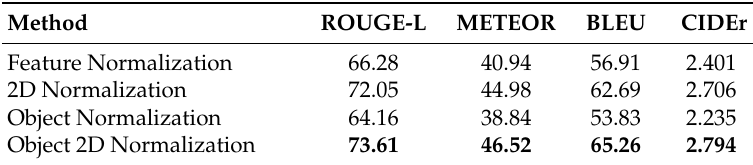
Table 5. Effect of different feature normalization methods on the translation performance. The results were obtained on the test set.